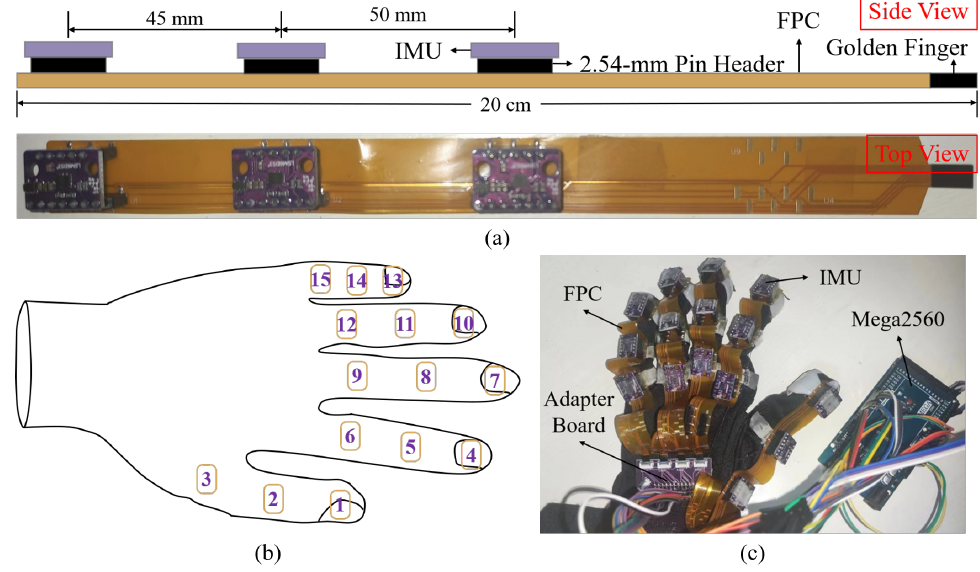
Figure 2. ( a ) Side view of the design drawing and top view of the prototype for an integrated FPC with three IMUs. ( b ) Placement of the IMUs on the glove. ( c ) Prototype of the data glove integrated with finger tracking